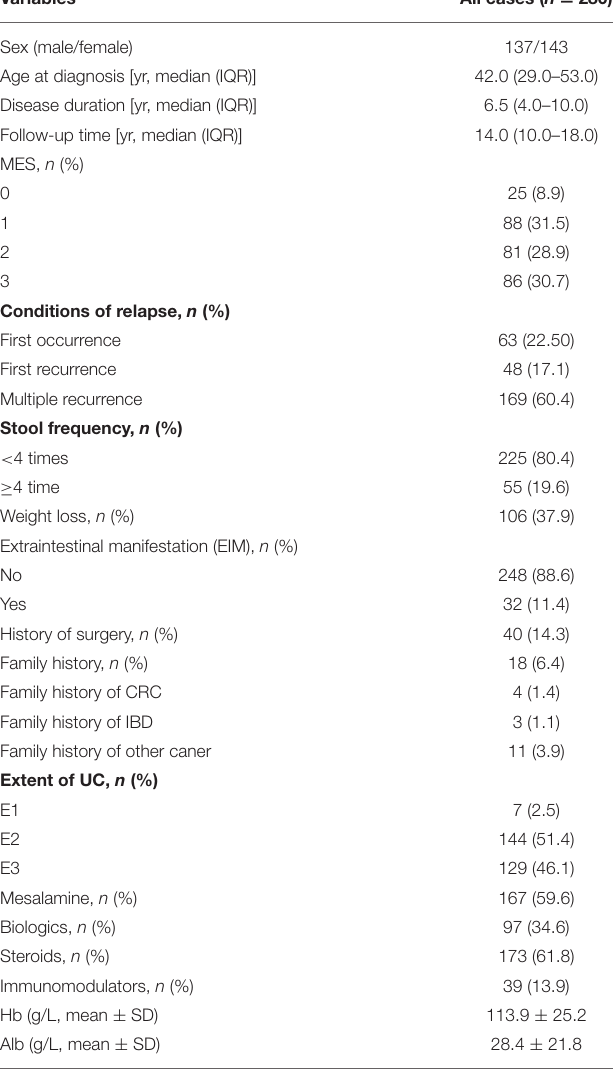
TABLE 2 | Comparison of clinical outcomes between patients with UC with low MES and high MES group.